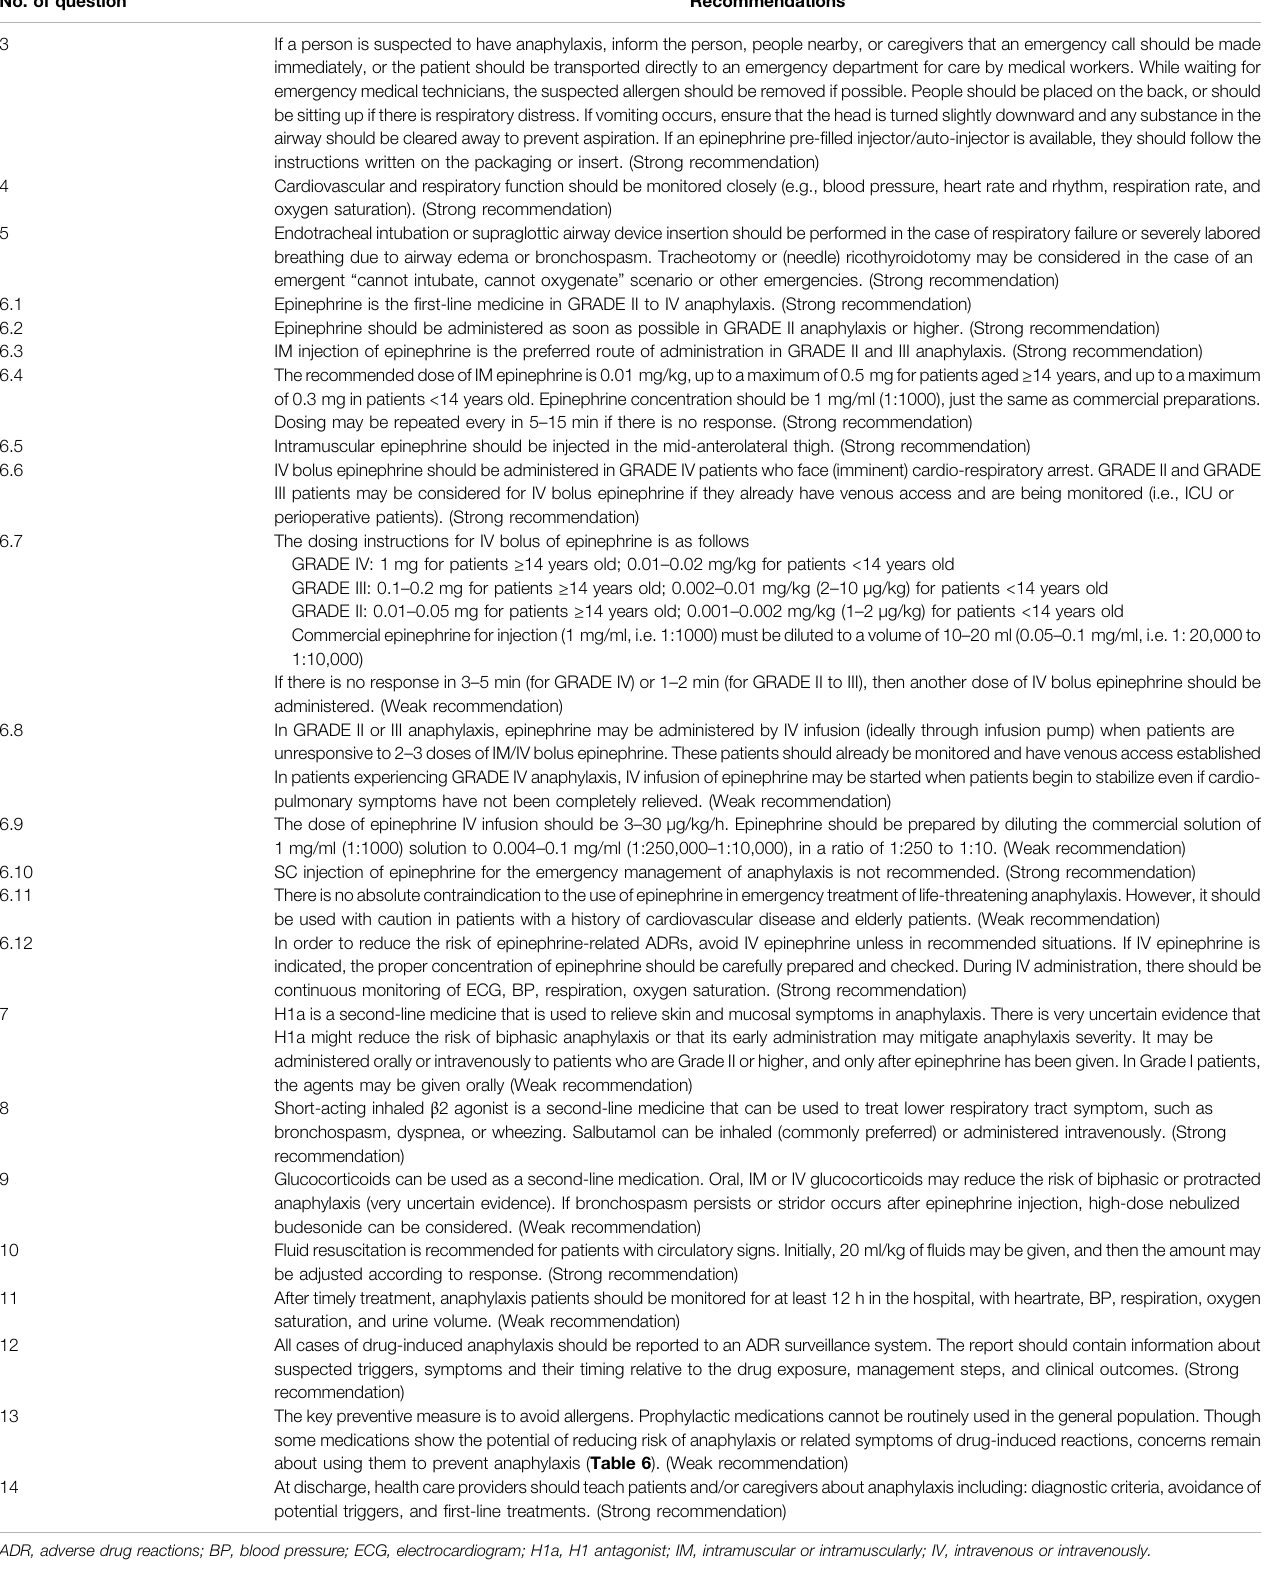
TABLE 2 | Summary of recommendations for emergency